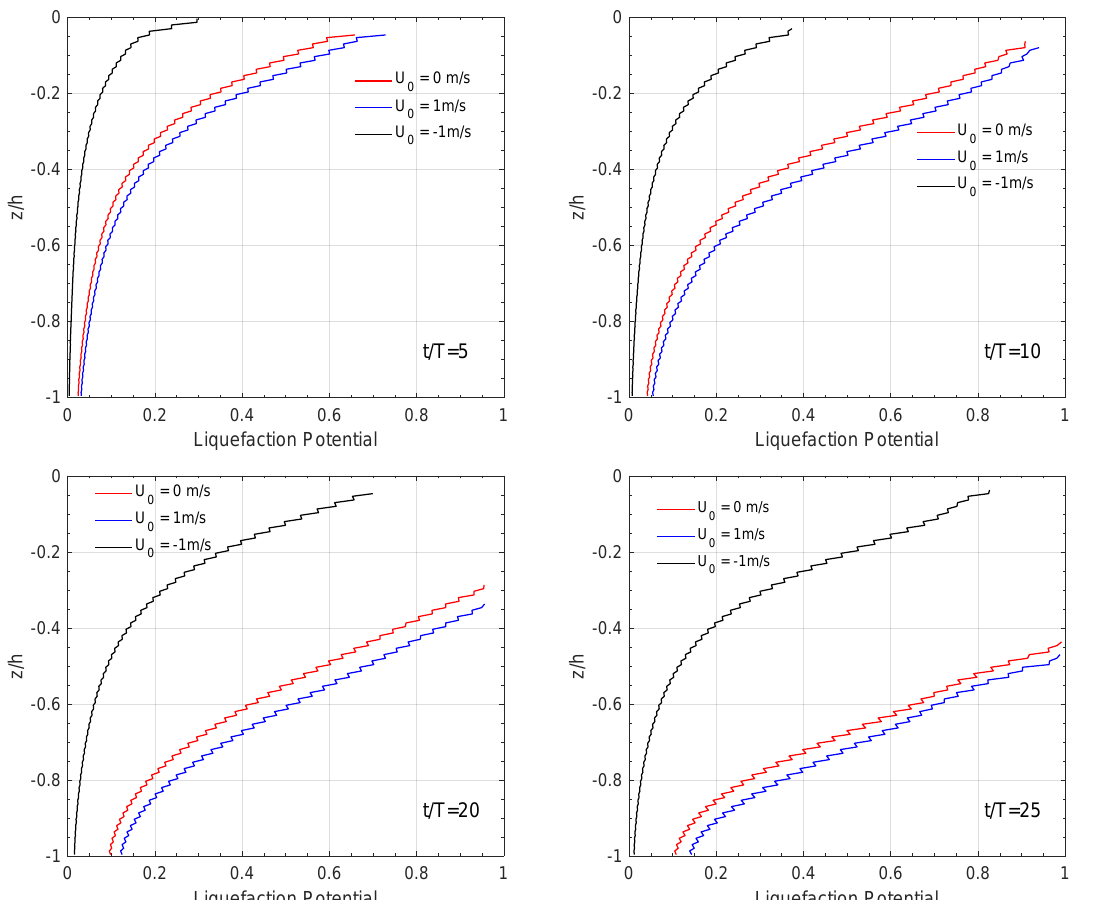
Figure 10. Effect of currents U 0 on the vertical distribution of liquefaction potential on z = − 5 m at four typical time